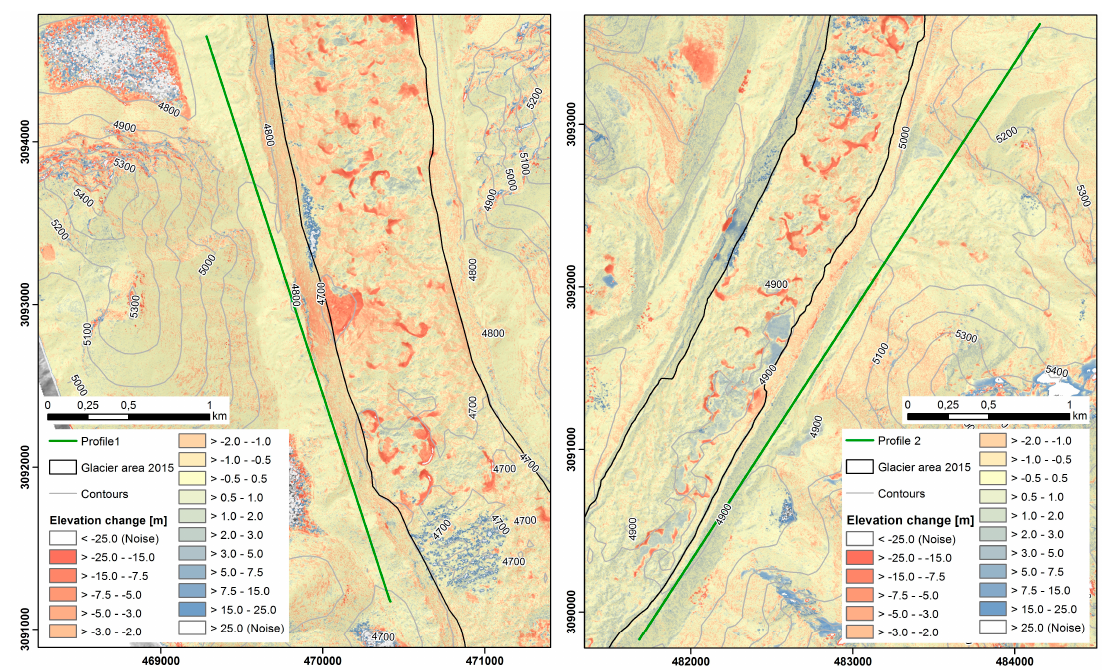
Figure 10. Post co-registration surface difference and location of profile 1 and profile 2 in the area of overlapping scenes west of the tongue of Ngozumpa glacier and east of the tongue of Khumbu glacier. The green line shows the location of the profile, and the surface differences in areas outside the glaciers are clearly visible. The high differences in the areas of unfrozen lakes are clearly visible.